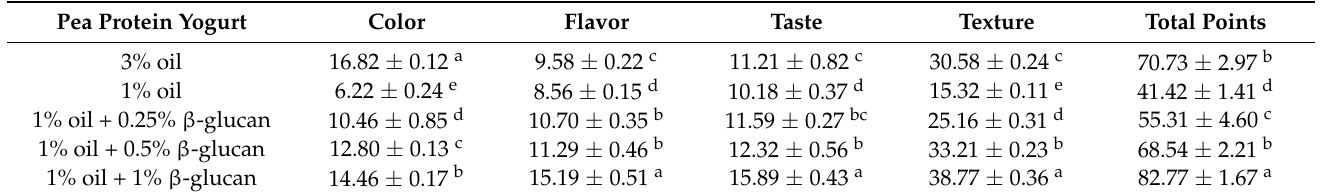
Table 2. Effects of oat β -glucan concentration on the sensory properties of pea-protein-based yogurt.